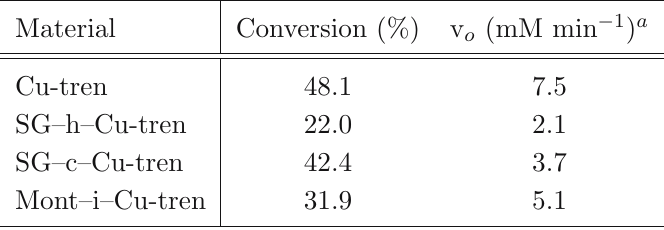
Table 2 Conversion and initial rate values for disproportionation of H 2 O 2 by the host- free and immobilised Cu-tren complexes (the reaction mixture always contained the same amount of Cu 2+ ).